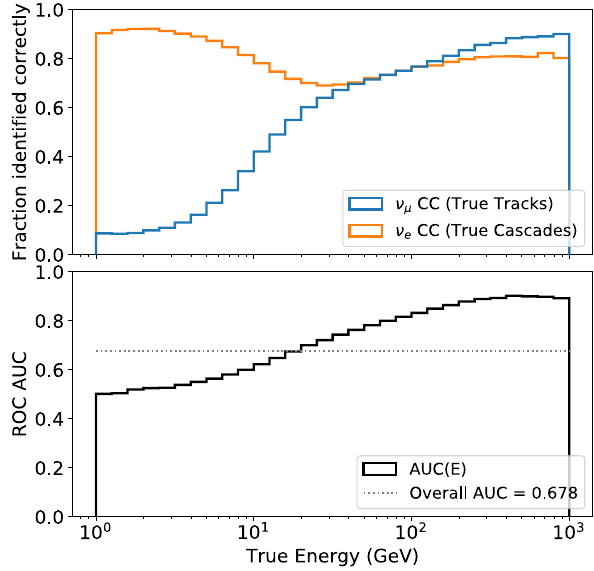
Fig. 15 The top panel shows the fraction of events classified correctly as a function of energy. The bottom panel shows the area under the curve (AUC) for the receiver operating characteristics (ROC) for each energy band. The classifier performance is better at higher energies, while towards the lowest energies the AUC converges to 0.5, i.e. zero classification